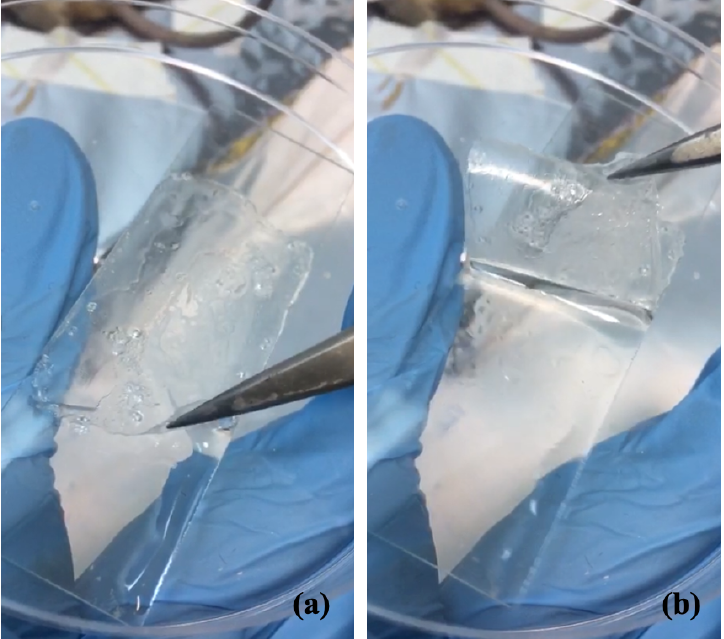
Figure 5. Patch manufactured from the formulation R = 4. ( a ) The material is easily detachable from the slide, by simple hydration. ( b ) The material is very flexible and easily adaptable to biological